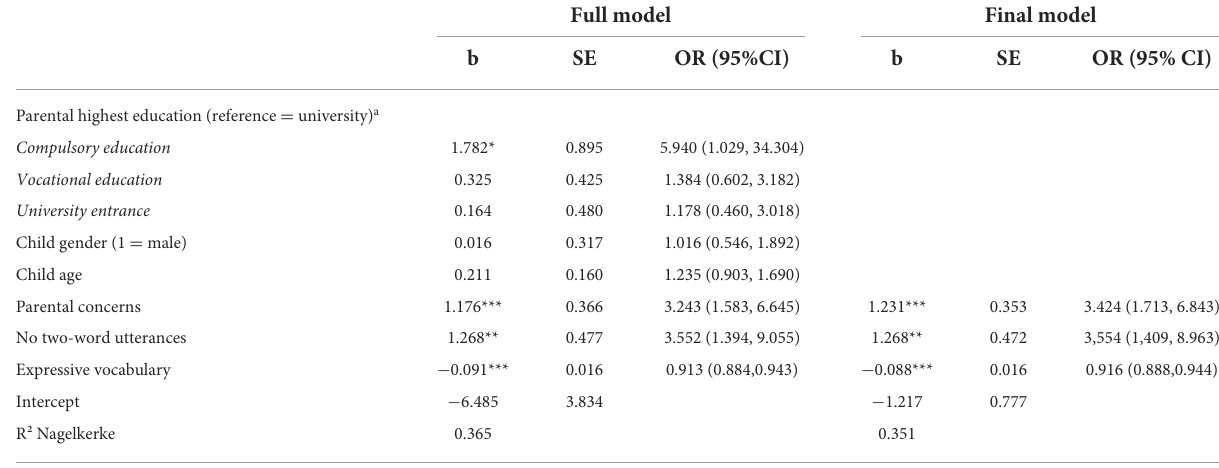
TABLE 2 Logistic regression predicting LD at age 3 – Stage 1.